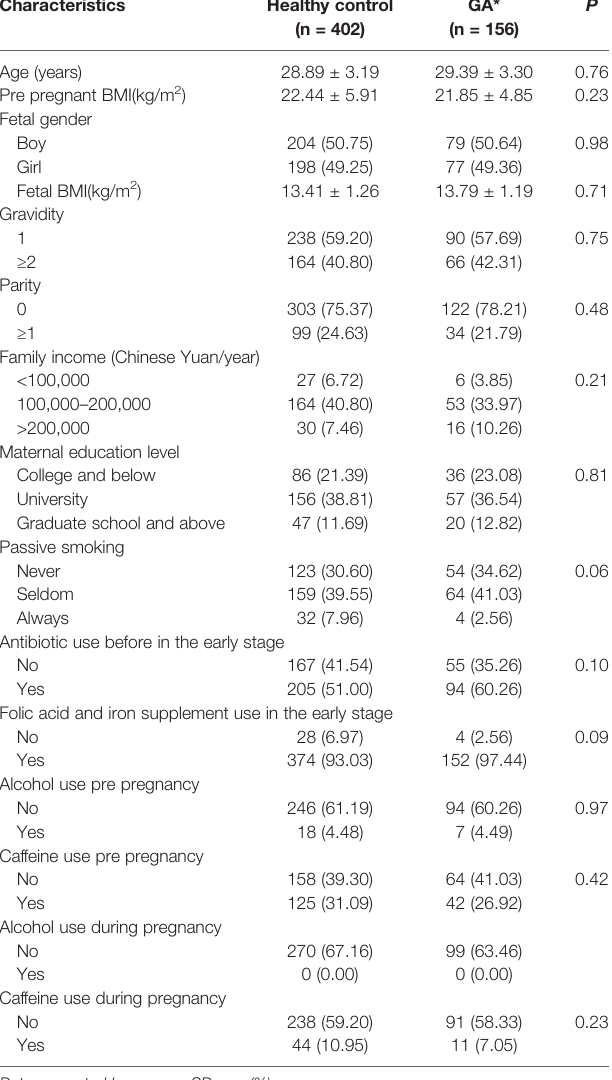
TABLE 1 | Characteristics of the study